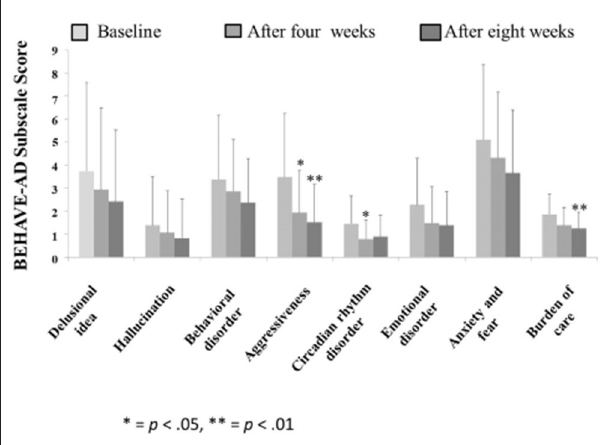
FIGURE 2 | The effects of YKSCH on BPSD items. Data were Behave-AD item scores (means ± SD and ranges) after YKSCH administration. Results were on 29 cases regarding “burden of care” and 28 cases otherwise. All excluded cases were dropped because of missing data. Ad hoc multiple comparison Tukey’s HSD tests (* p < 0.05, ** p < 0.01) were compared to baseline.